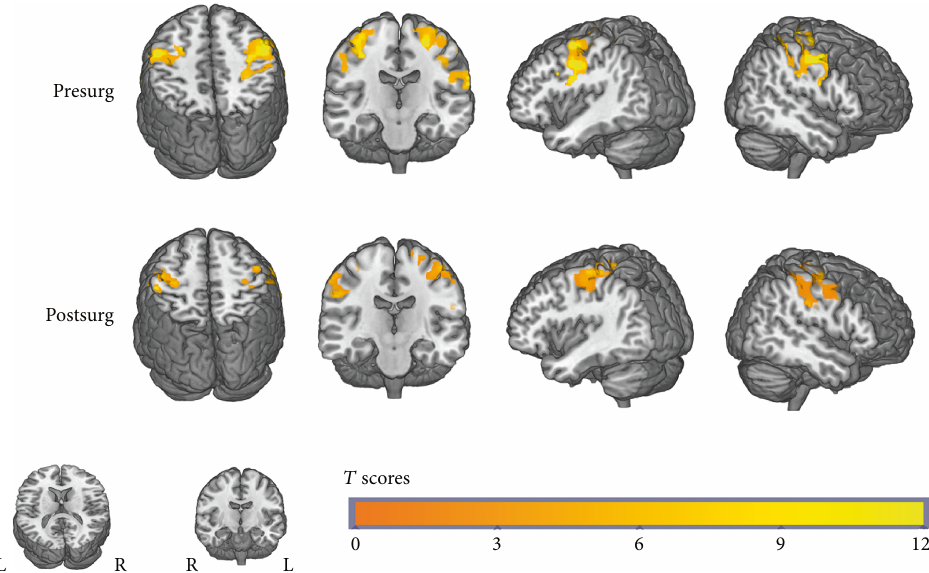
Figure 1: Activation pattern before and after surgery. The fi rst row of the fi gure shows the activation pattern of the presurgery group through one-sample t -test. And the second row shows the pattern of the postsurgery group. The extent of the activation area of the presurgery group is much larger than that of the postsurgery group. Other activation areas have been hidden in the fi gure, which aims to minimize visual